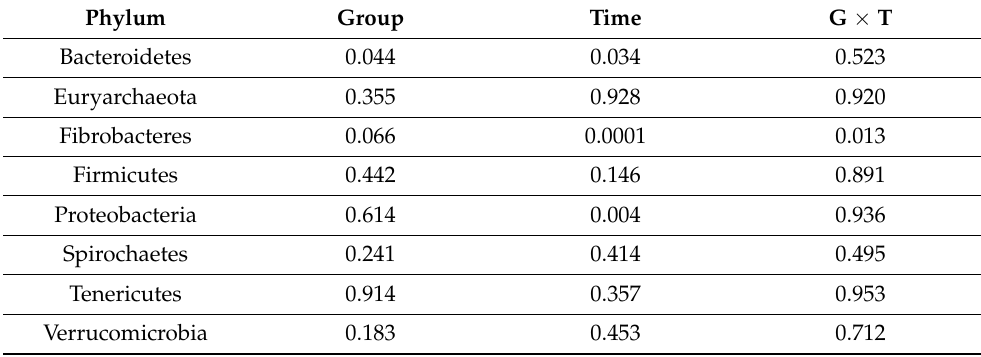
Table 6. p -values associated with the statistical analysis of the relative abundances of the bacterial and archaeal communities in the fecal samples with a linear mixed model. Phylum Group Time G × T 0.044